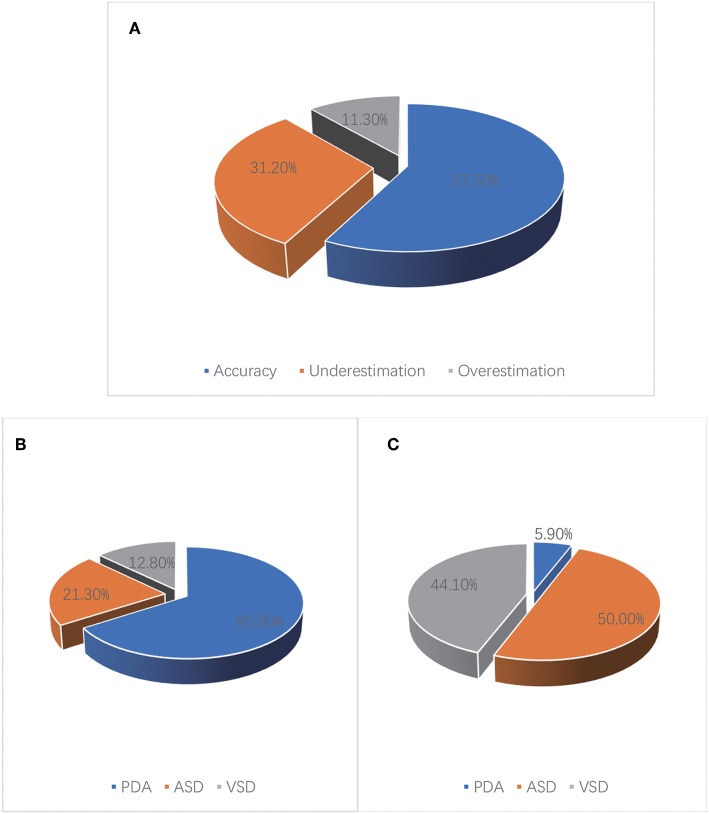
Accuracy of sPAP estimated by D-ECHO in 301 children with CHD. (A) A total of 57.5% of D-ECHO estimates were found to be accurate, 31.2% of D-ECHO estimates were found to be underestimated, 11.3% of D-ECHO estimates were found to be overestimated. (B) In patients with underestimated pressure, it was found that PDA accounted for 65.9%, ASD accounted for 21.3%, and VSD accounted for 12.8%. (C) In patients with overestimated pressure, it was found that PDA accounted for 5.9%, ASD accounted for 50.0%, and VSD accounted for 44.1%.